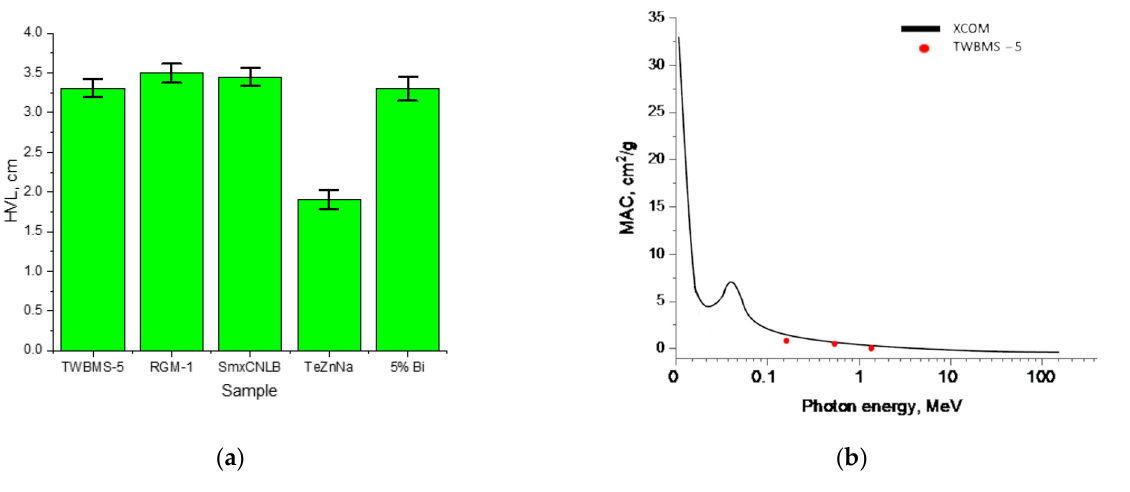
Figure 9. ( a ) Results of a comparative analysis of the HVL value for different types of glasses (RGM–1–a sample of soda-lime-silica glass doped with MoO 3 [40]; SmxCNLB glasses–glass samples doped with Sm 2 O 3 [47]; TeZnNa–tellurite glass system containing ZnO and Na 2 O [33]; 5%Bi 2 O 3 –65%P 2 O 5 –5%B 2 O 3 –25%Na 2 O [27]); ( b ) results of comparison of MAC values calculated using the XCOM program code and experimentally obtained values for the TWBMS–5 glass composition.